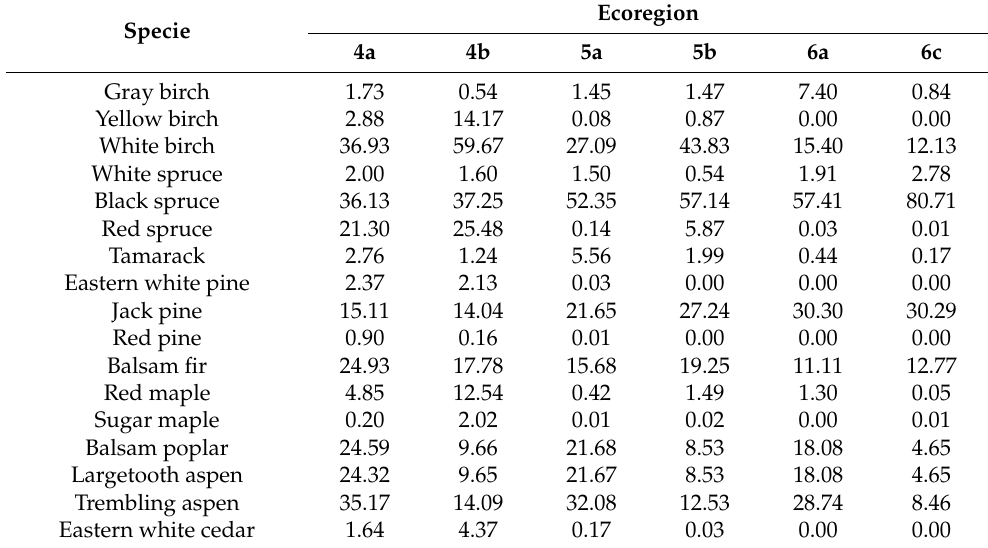
Table 3. Species establishment